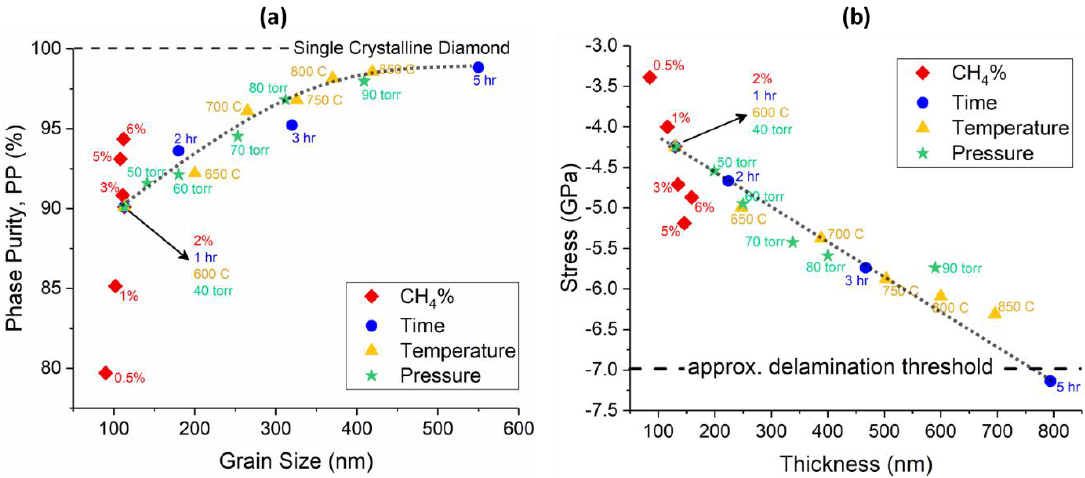
Figure 10. ( a ) Phase purity versus grain size of the diamond layer. ( b ) Residual stress as a function of film thickness. lines are guides to the eye only, for both of the figures.